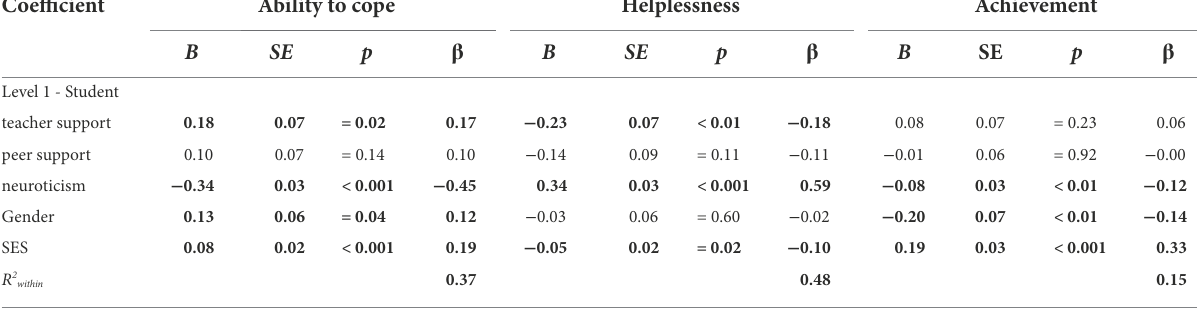
TABLE 3 Results of multilevel structural equation